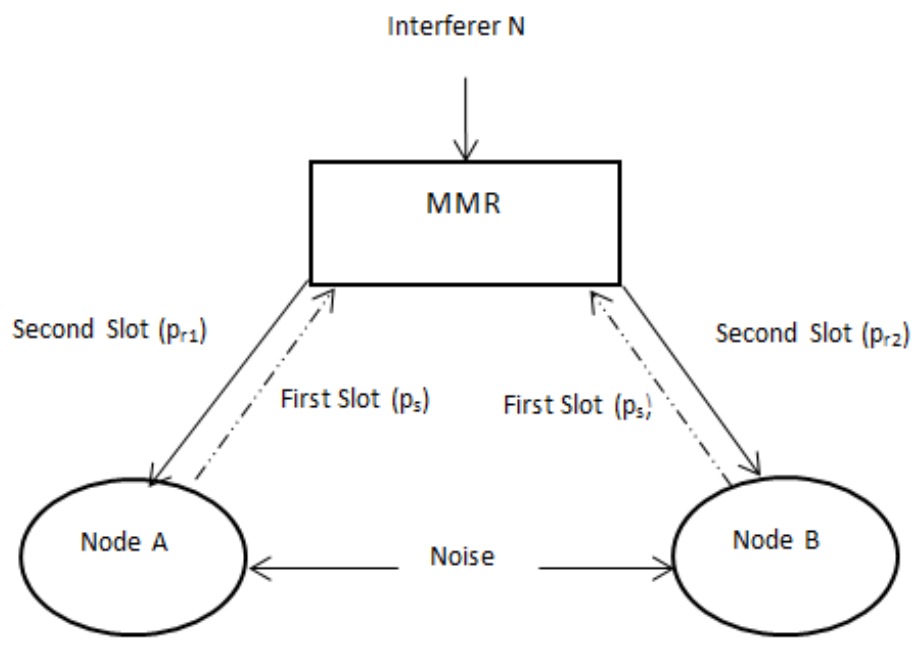
Figure 3. System model of multi-mode relay p r 1 (cid:54) = p r 2